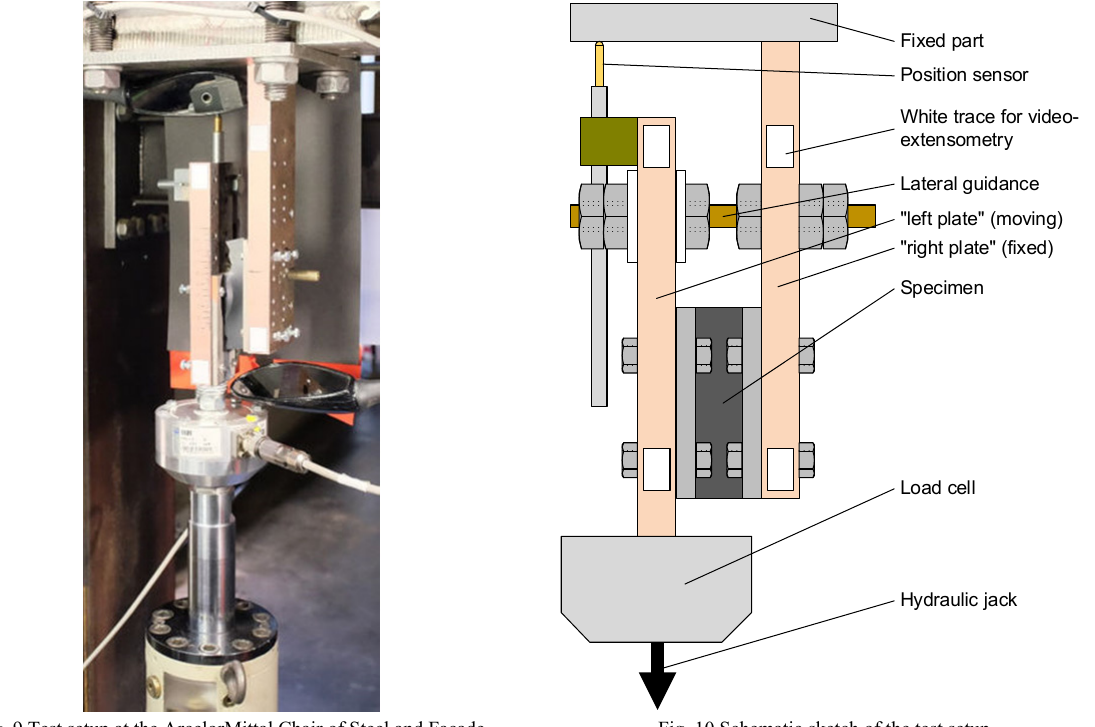
Fig. 9 Test setup at the ArcelorMittal Chair of Steel and Façade Engineering